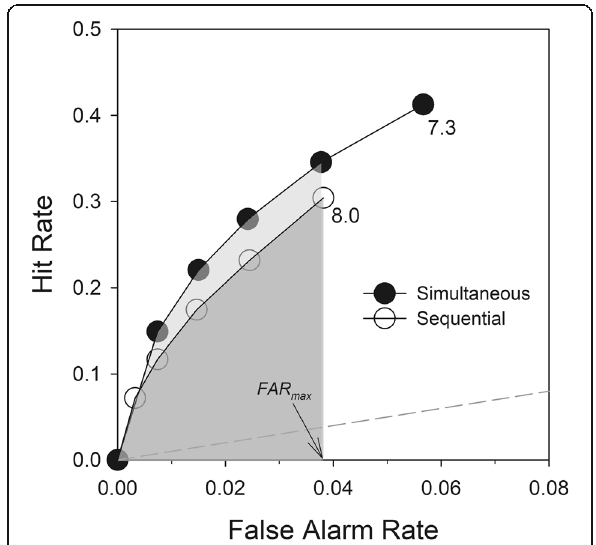
Fig. 5 Hypothetical receiver operating characteristic (ROC) curves for two eyewitness identification procedures in which a 5-point confidence scale was used. The rightmost ROC point again represents the overall correct and false positive identification (ID) rates that are ordinarily used to compute the diagnosticity ratio. Note that the diagnosticity ratio for the rightmost point is higher for the sequential procedure, a result that, in the past, would have been interpreted to mean that the sequential procedure is diagnostically superior to the simultaneous procedure. The region shaded dark gray represents the partial area under the curve (pAUC) for the sequential procedure in the specified false ID rate range of 0 to FAR max . That dark gray region plus the light gray region above it represents the pAUC for the simultaneous procedure over the same false ID rate range. The dashed line represents the line of chance